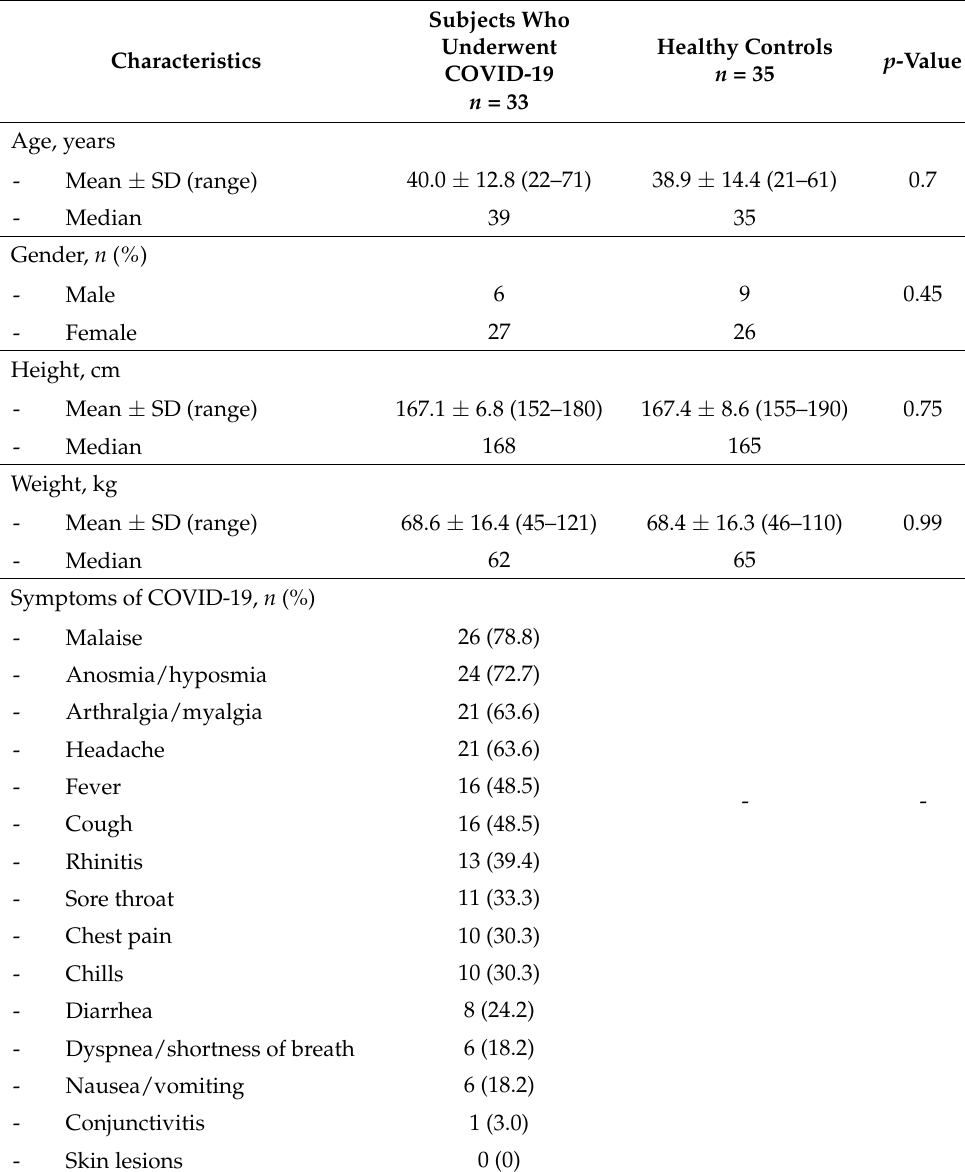
Table 1. Clinical characteristics of study participants (SD, standard